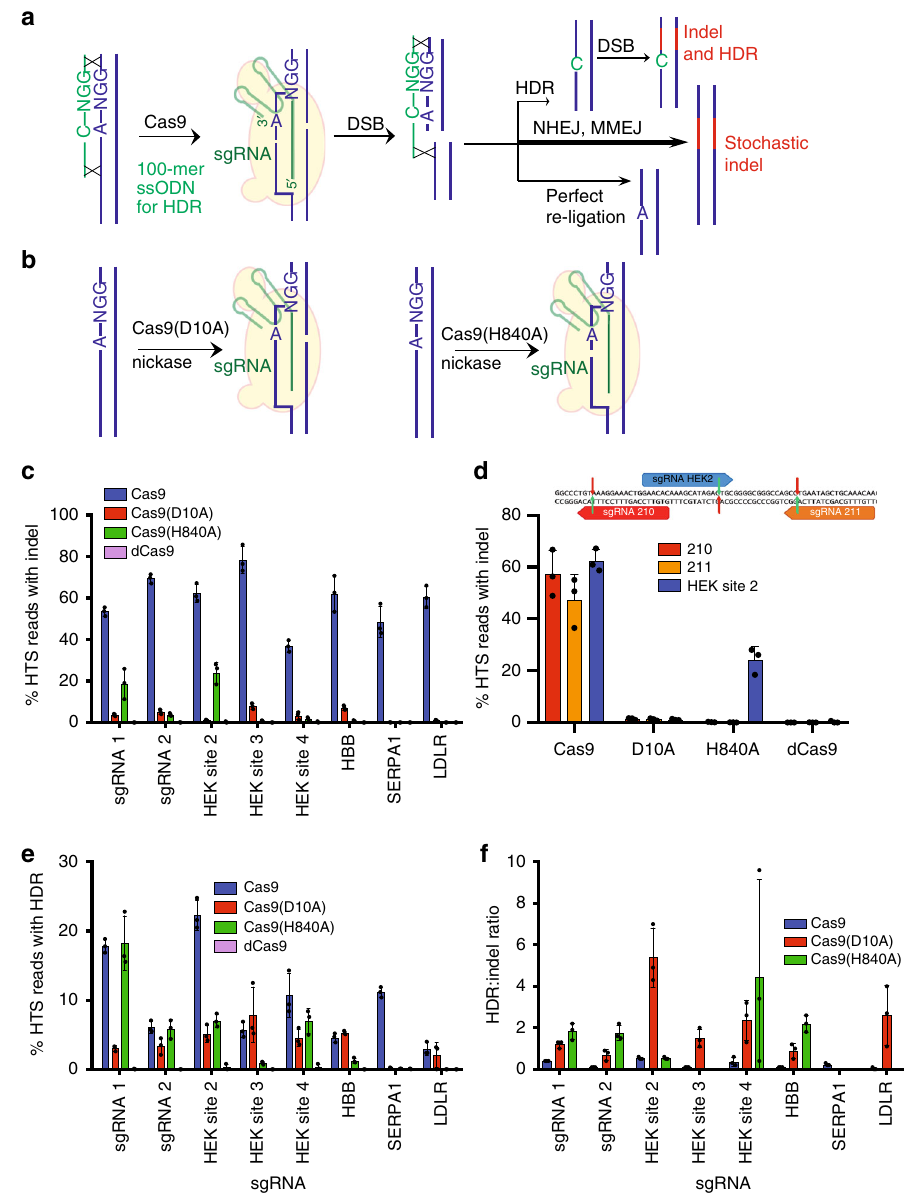
Fig. 1 Indel formation and HDR in HEK293T cells mediated by Cas9 or Cas9 nickases. a DSB-mediated HDR using Cas9 and a 100-mer ssODN. b DNA nicks resulting from Cas9(D10A) or Cas9(H840A) nickase. c Indels resulting from Cas9 nuclease, Cas9 nickase, or dead Cas9 at eight loci in HEK293T cells. d Comparison of indel frequencies associated with three sgRNAs in close proximity. The sgRNA sequences used in are shown, with red arrows indicating nicks induced by Cas9(D10A) nickase, and green arrows showing nicks by Cas9(H840A) nickase. e HDR frequencies, measured by high- throughput DNA sequencing of unsorted HEK293T cells at eight endogenous genomic loci. f HDR:indel ratio associated with editing at eight loci. All data are shown as individual data points and mean ± s.d. for n = 3 independent biological replicates, performed on different days. Source data are provided in the Source Data fi